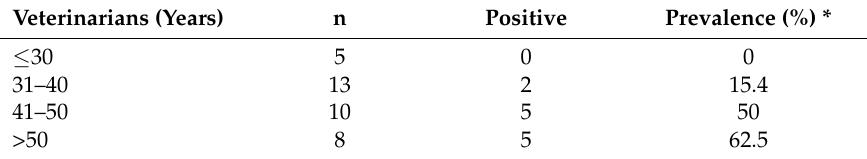
Table 1. OPV-specific antibodies in veterinarians, Friuli Venezia Giulia (Northeastern Italy). Veterinarians (Years) n